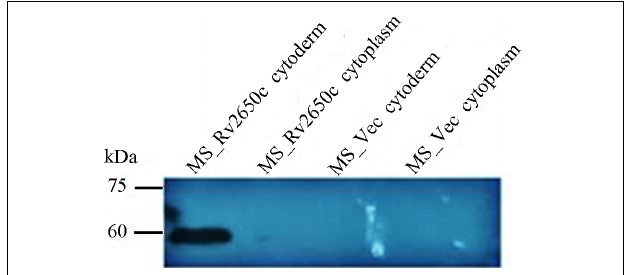
FIGURE 1 | The prophage protein Rv2650c is localized on the cell